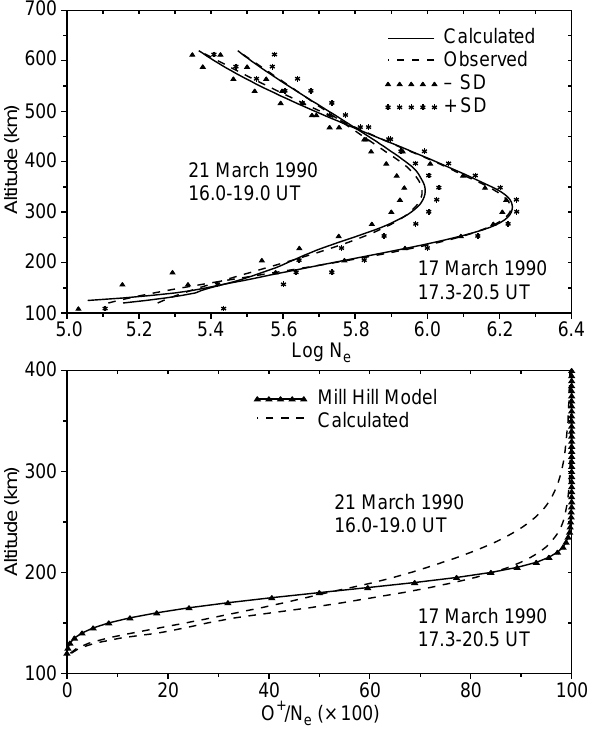
Fig. 3. Observed and calculated N e (h) profiles for geomagnetically quiet March 17 and disturbed March 21, 1990 days (top panel). The standard deviations of the observed values are indicated. Calculated profiles closely match the observations on both days. Calculated O (cid:135) / N e height variations are shown for the two days (bottom panel) and these are compared to the non–varying Millstone Hill standard ion– composition model